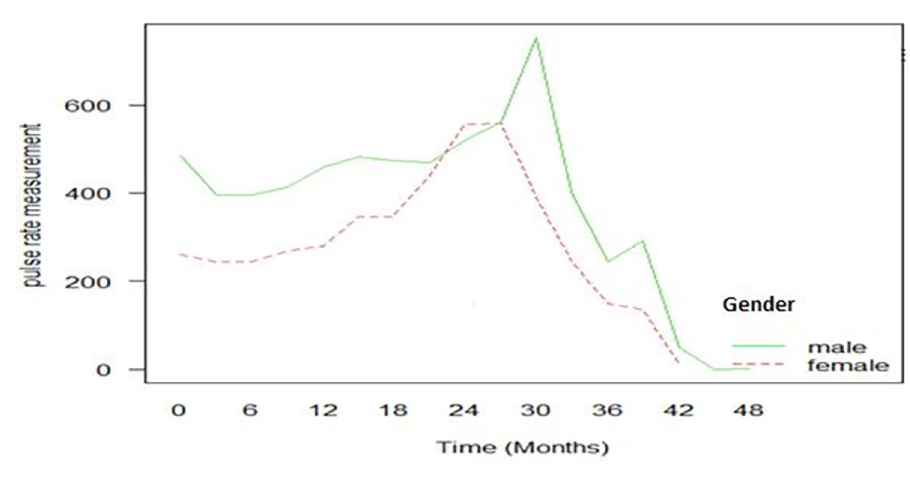
Fig 2. In addition, for Cox proportional hazard model, proportional hazard assumption was tested for each categorical covariate. Hence, P-value of individual covariate and GLOBAL test statistic are greater than 5% level of significance, indicating that all covariates satisfied the pro- portionality assumption of the Cox model (result not shown here). Following the development of separate models, Bayesian joint model that links longitudinally measured pulse rate to the survival time to death was performed using JMbayes2 package in R software version 4 . 2 . The Gibbs sampler algorithm was implemented with 20,000 iterations in three different chains ini- tialized with over dispersed values for all parameters. Then, samples generated from the full posterior distribution are used to make inference about the joint model parameters. Before undertaking any inference from posterior distribution the convergence of generated Markov chains has been verified by density plot (Fig 3) and time series or history plot (Fig 4). Fig 3 shows density plots for only some selected statistically significant regression coefficients in the joint model and simulated samples from posterior distribution for each regression coefficient